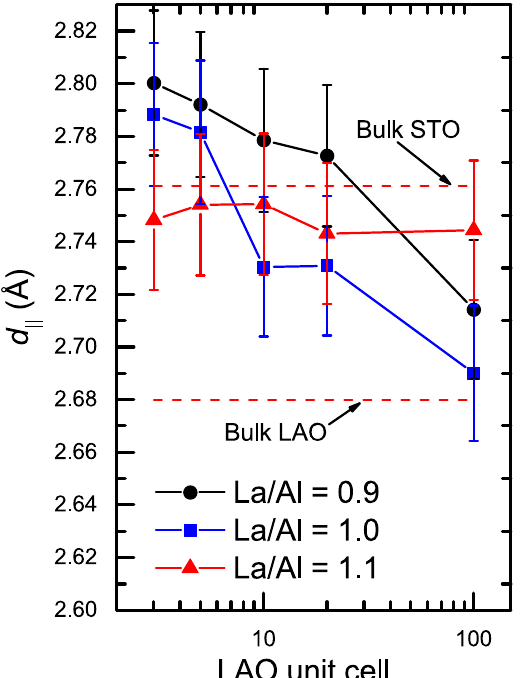
Figure 4. Variations of interatomic spacing d film thickness for different La/Al ratios. The dashed lines are the d